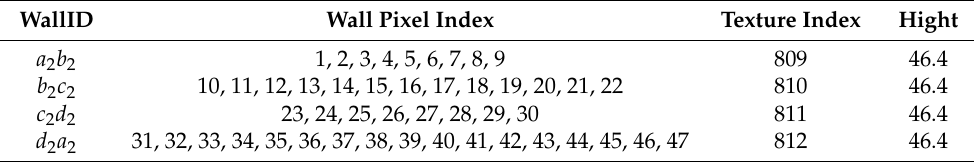
Table 5. The building wall texture index in Figure